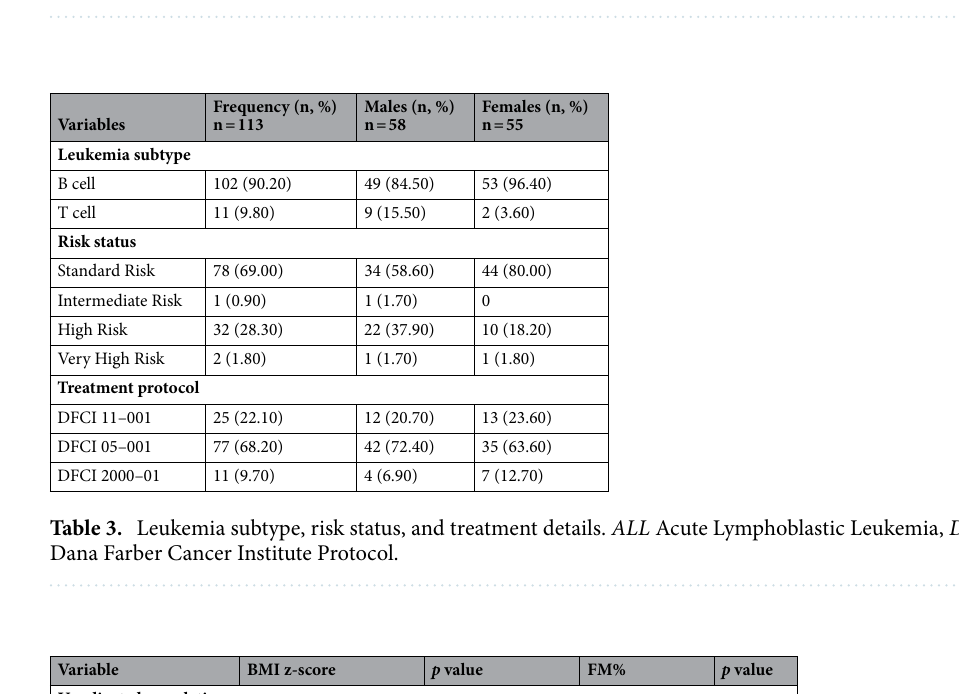
Table 2. Anthropometric and DEXA data in survivors of childhood ALL. TMI triponderal mass index, BMI body mass index, SD standard deviation.